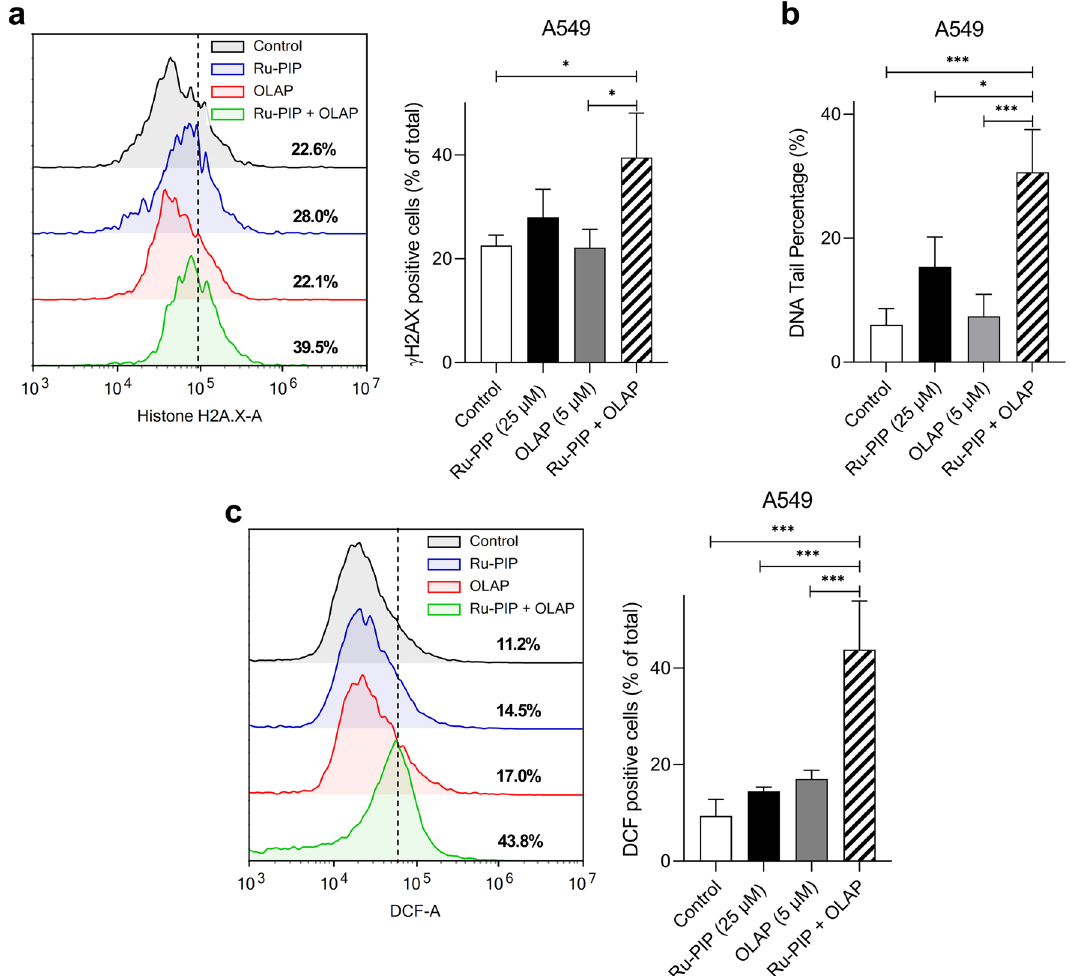
Figure 4. Ru-PIP and Olaparib combination induces DNA damage. ( a ) Left, γH2AX levels upon treatment with Ru-PIP (25 µM), Olaparib (5 µM) or both for 24 h in A549 cells, determined by immunofluorescence and flow cytometry analysis. Right, the percentage of γH2AX positive cells in each population was determined by gating of histograms derived from single-stained cells, as in part a. ( b ) Evaluation of DNA damages upon treatment with Ru-PIP (25 µM), Olaparib (5 µM) or both for 24 h by comet assay. Bar graphs showing the DNA tail percentage (%) in A549 cells, which was used as the parameter for DNA damages. ( c ) Left, histograms showing the fluorescence intensities of 2’,7’-dichlorofluorescein (DCF) upon treatments, as measured by flow cytometry. Right, the ROS levels in A549 cells upon treated with Ru-PIP (25 µM), Olaparib (5 µM) or both for 24 h. Mean ± SD of three independent experiments. * P < 0.05, *** P < 0.001 by tion of Olaparib (5 mg/L) showed higher survival compared to Ru-PIP single-agent with 96 h LC 50 of 92.8 mg/L. Subsequently, hatching rate upon treatment was also measured in which hatching time normally occurs from 48 hpf (hours post fertilization) to 72 hpf. This is also regarded as an important endpoint toxicity parameter as this will impair their development, inducing other developmental toxicity and eventually, a lethal outcome. Figure 6b shows treatments with 100 mg/L of Ru-PIP or cisplatin prevented almost 100% embryos’ hatching with other works have previously reported the inhibition of zebrafish hatching by cisplatin 40,41 . However, most encourag- ingly, treatment with 100 mg/L of Ru-PIP in combination with 5 mg/L Olaparib improves hatching rate to 50%. Next, morphological assessment of the embryos upon treatments with the stated compounds was conducted to observe sublethal effects including pericardial edema, yolk sac edema and spinal deformity. The embryos were not accessed for morphological changes upon treated with 100 mg/L of Ru-PIP or cisplatin as the embryos did not survive or they remain unhatched. Notably, upon treated with > 25 mg/L of Olaparib, the embryos showed substantial morphological abnormalities of pericardial edema, yolk sac edema and spinal deformity (Fig. 7a,b). Treatment with 50 mg/L of Ru-PIP alone led to 33% of the embryos showing yolk sac edema, meanwhile treat- ment with cisplatin at any concentration did not show any morphological changes. Morphological changes were also observed in embryos treated with > 50 mg/L of Ru-PIP in combination with subtoxic concentration of Olaparib (yolk sac edema and spinal deformity, 33%; and pericardial edema, 16%). Overall, although Ru-PIP single-agent at high concentrations showed lower survival in comparison to cisplatin, its combination with